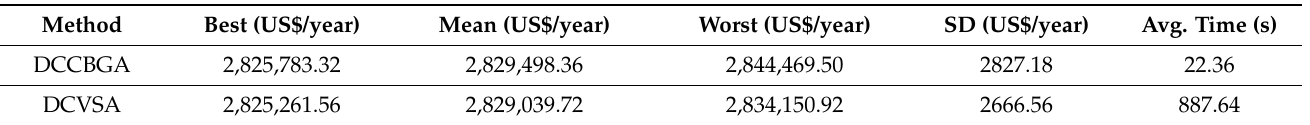
Table 5. Numerical performance comparison between the DCVSA and DCCBGA in the IEEE 69-bus system after 100 consecutive